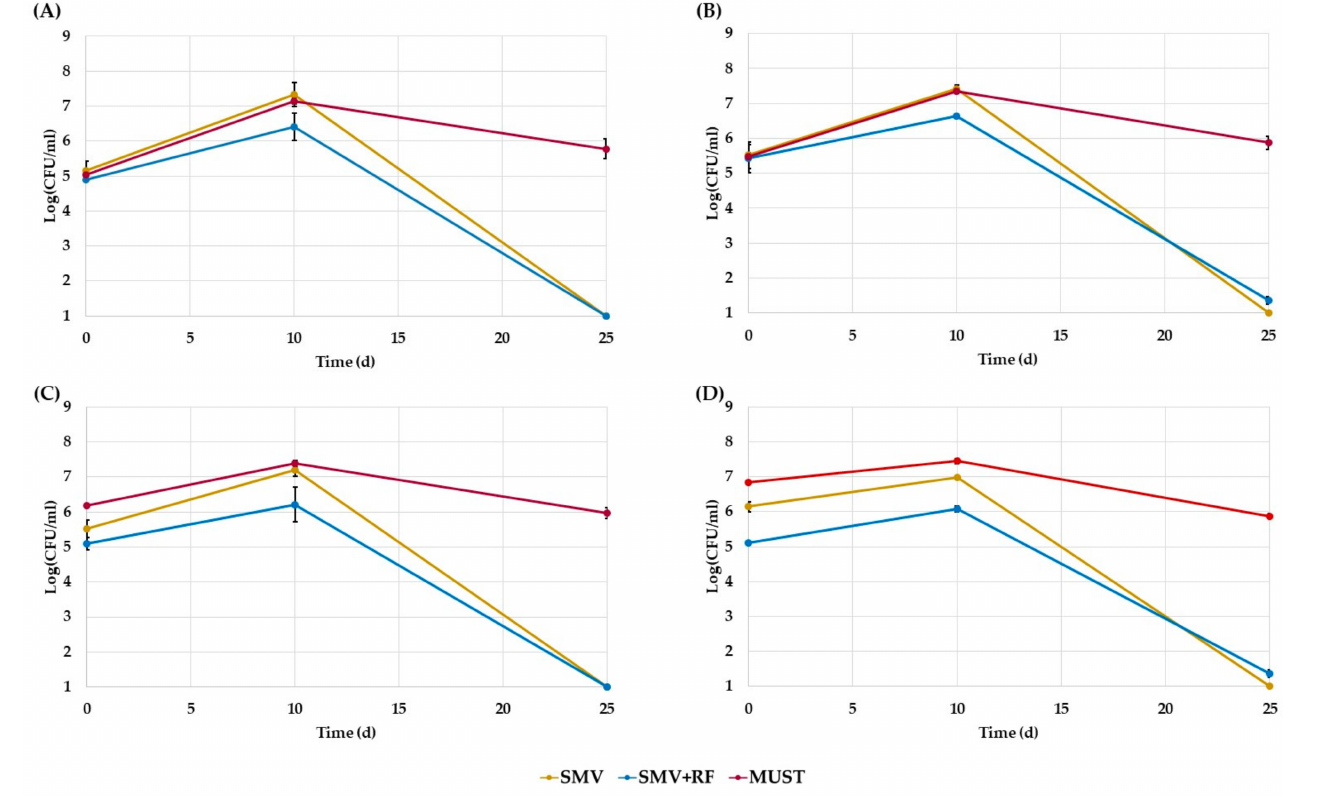
Figure 1. Trends of viable counts expressed as Log CFU/mL of the four strains in the three growth media (SMV = dark yellow line, SMV+RF = blue line, MUST = red line): ( A ) EC1118; ( B ) IOC18-2007; ( C ) LS2; ( D ) AWRI796. The results are reported as average data of three replicates, and the error bars indicate the standard